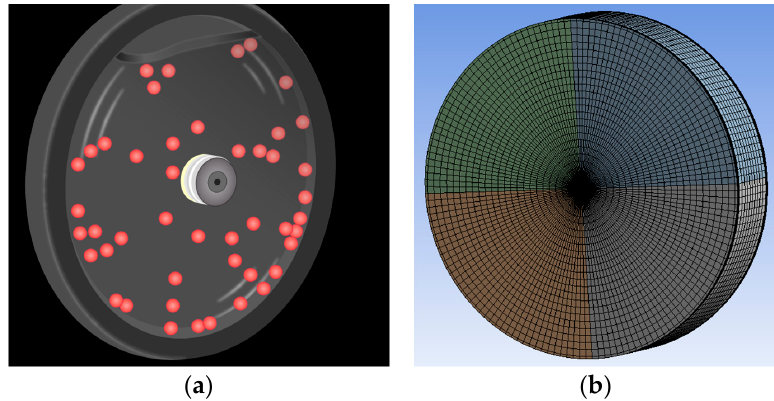
Figure 3. Graphical illustration of the simplified reactor solid model and the generated computational grid for the numerical simulation. ( a ) CAD model; ( b ) Hex mesh.